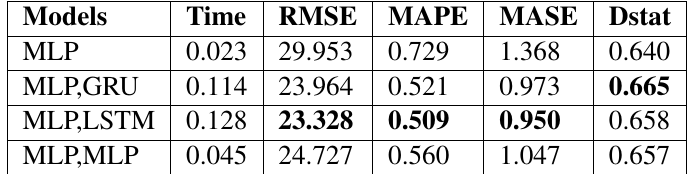
Table 3 The experiment results (NN1: MLP, DATA SET: